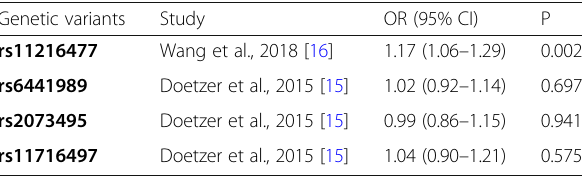
Table 3 Association of other genetic variants in LTF with dental caries Genetic variants